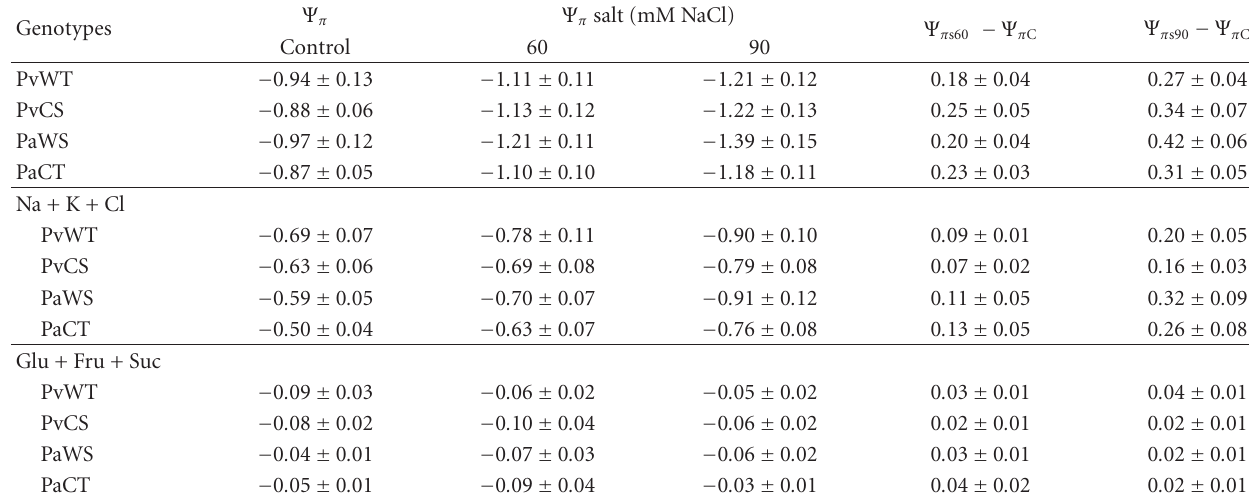
Table 3: Leaf water relations (MPa) of Phaseolus species after 20 days salt exposure z